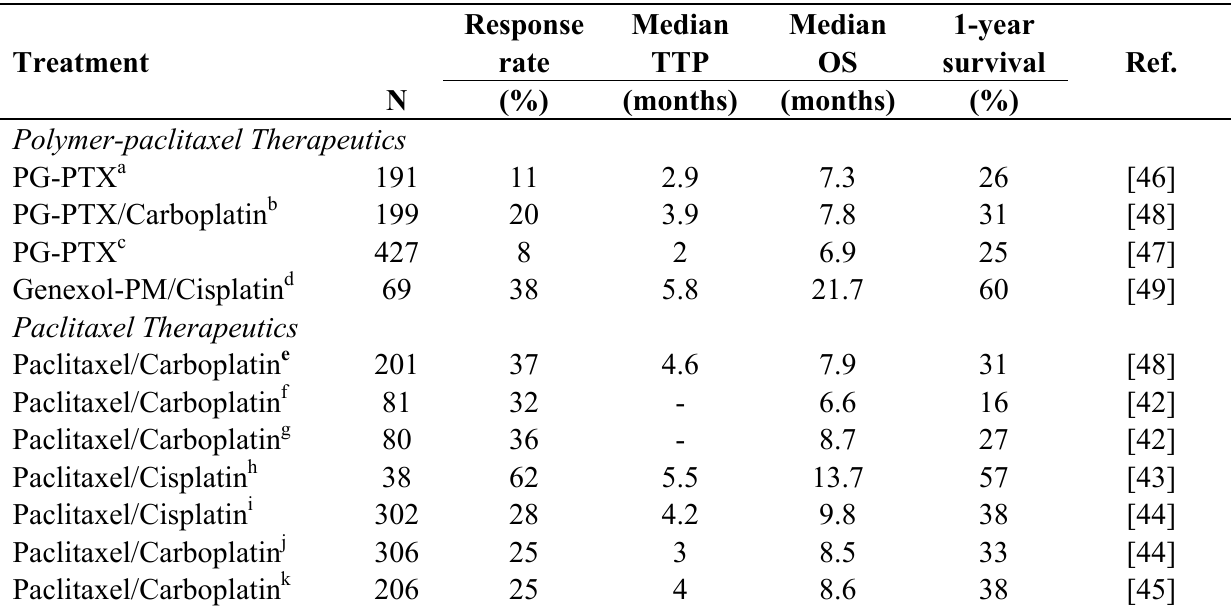
Table 12. Clinical outcomes of polymer paclitaxel and paclitaxel therapy in patients with non-small cell lung